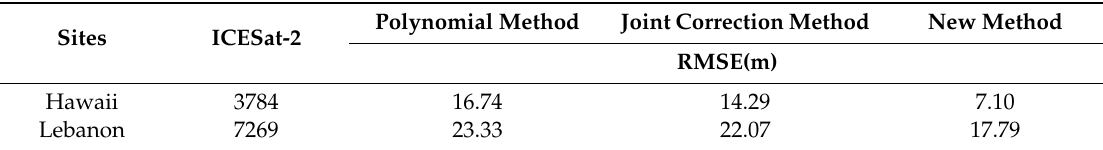
Table 1. Performance of the InSAR DEMs with di ff erent correction methods at study sites Hawaii